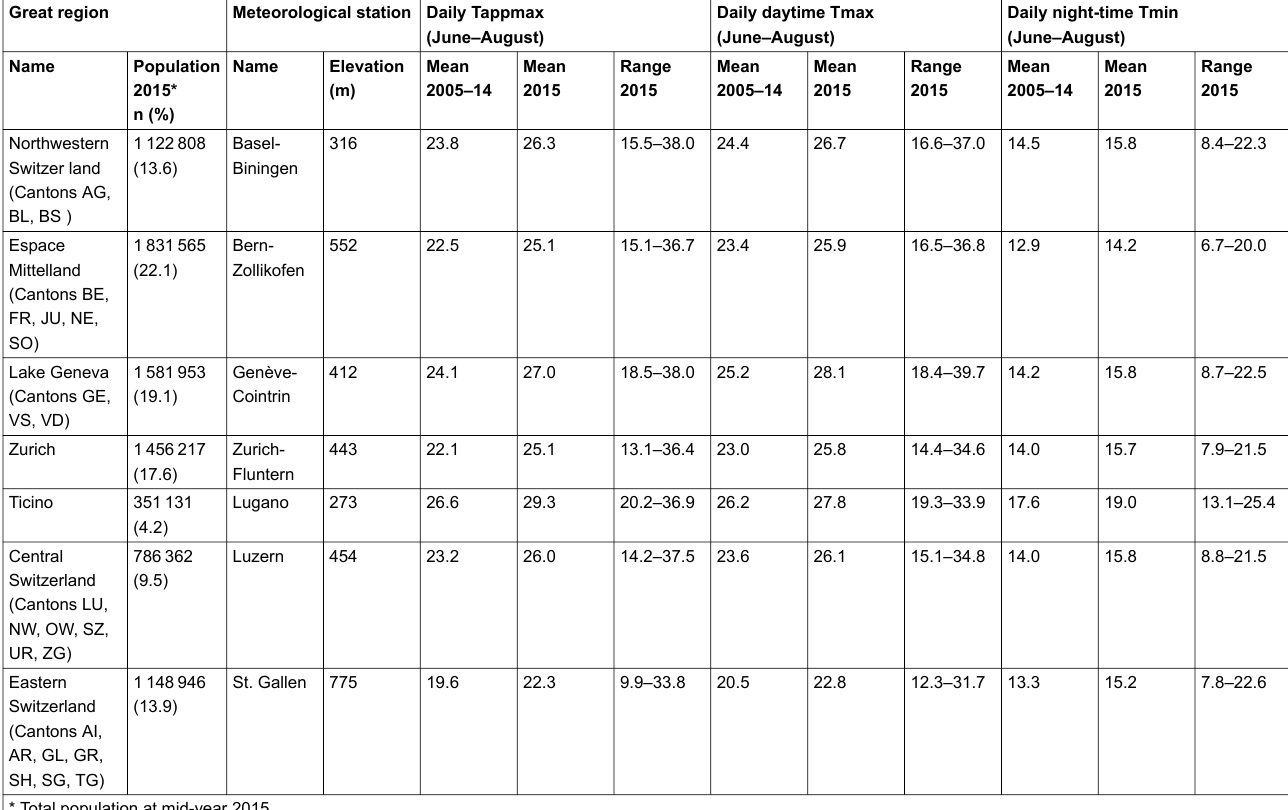
Table 1: Description of the population and meteorological conditions in the seven Swiss regions over the period 2005 to 2015. Great